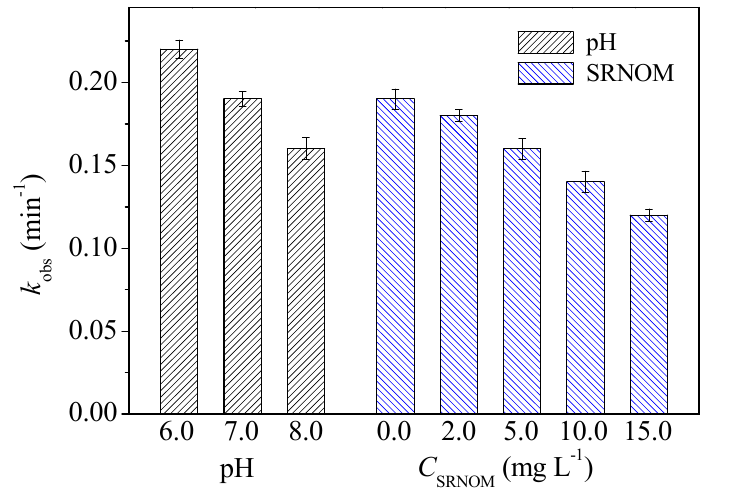
Figure 3. Observed degradation rate constant ( k obs ) of CTZ in UV/chlorine system in different pH or in the presence of SRNOM with different initial concentrations ([CTZ] 0 = 10 µM, (Free chlorine) 0 = 100 µM. The error bars represent the 95% confidence interval ( n = 3)).